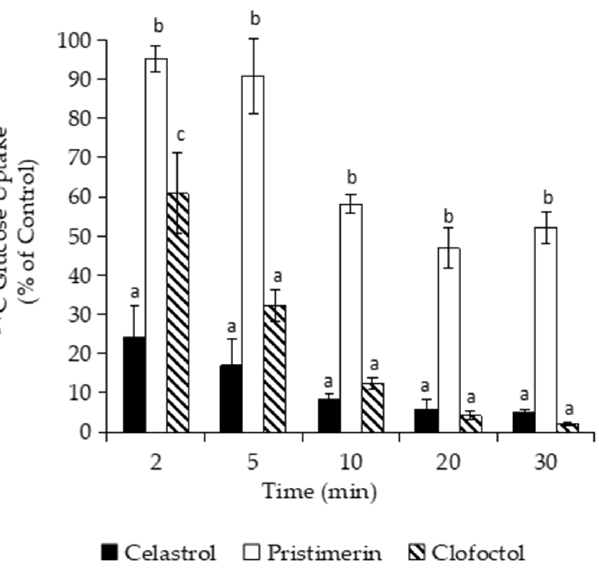
Figure 4. Glucose uptake assay on B. subtilis cultures after the addition of the quinones celastrol (3 µg/mL) and pristimerin (10 µg/mL). Clofoctol (5 µg/mL), a known inhibitor of